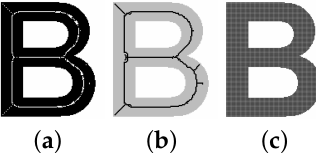
Figure 1. Illustration of Jang and Chin’s MST-based reconstructable parallel thinning. ( a ) Feature pixels obtained from the MST, ( b ) the final skeleton containing reduced feature pixels, feature pixels and the unit-width pixels to ensure pattern reconstruction, as well as ( c ) the reconstructed